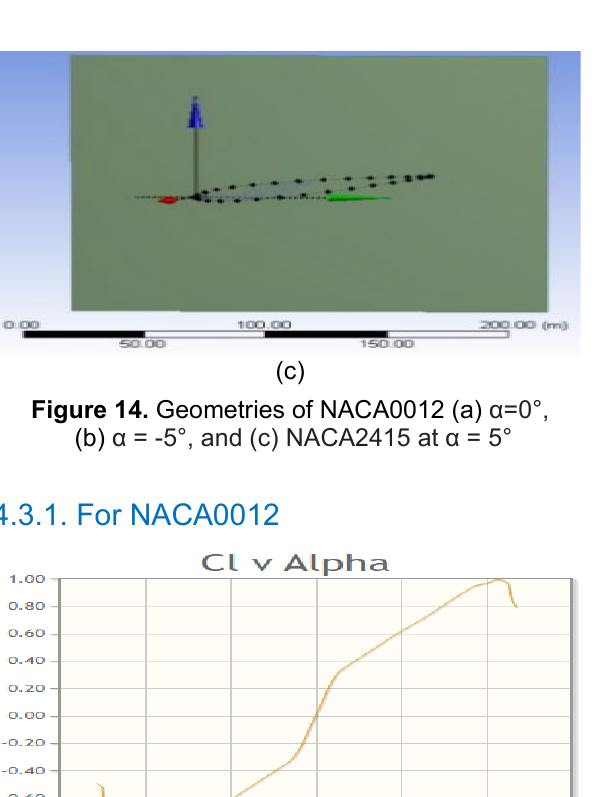
Figure 13. Coefficient of lift vs drag